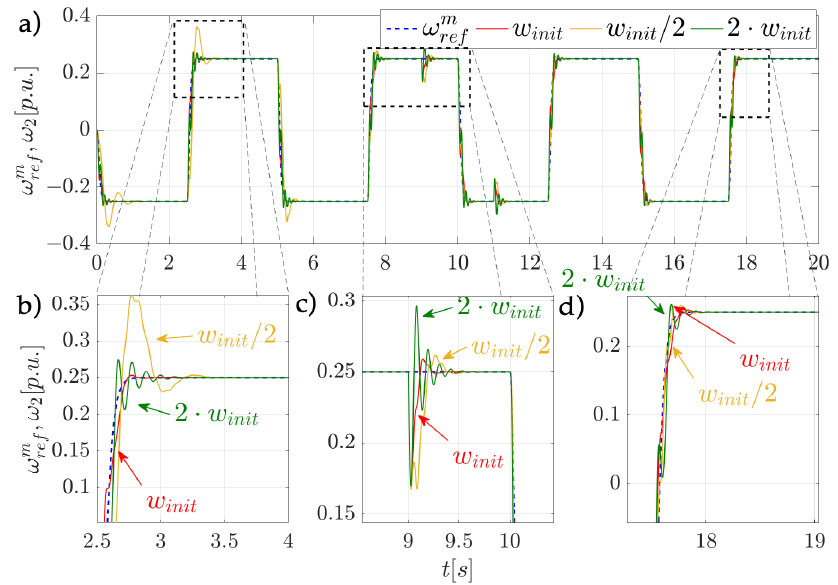
Figure 14. The impact of different initial values of weights in the adaptive speed controller based on the RWNN ( a ), the initial part of the simulation ( b ), applying load torque ( c ), the final part of the simulation ( d ).